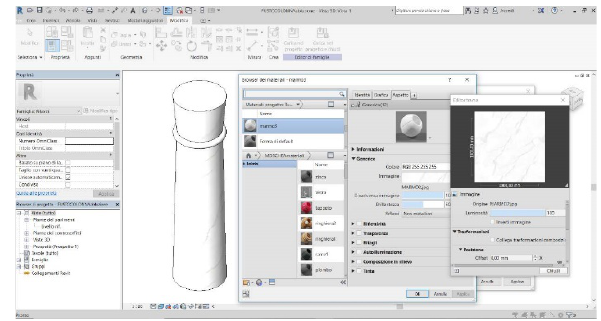
Figure 10. Customizable library collecting types of material